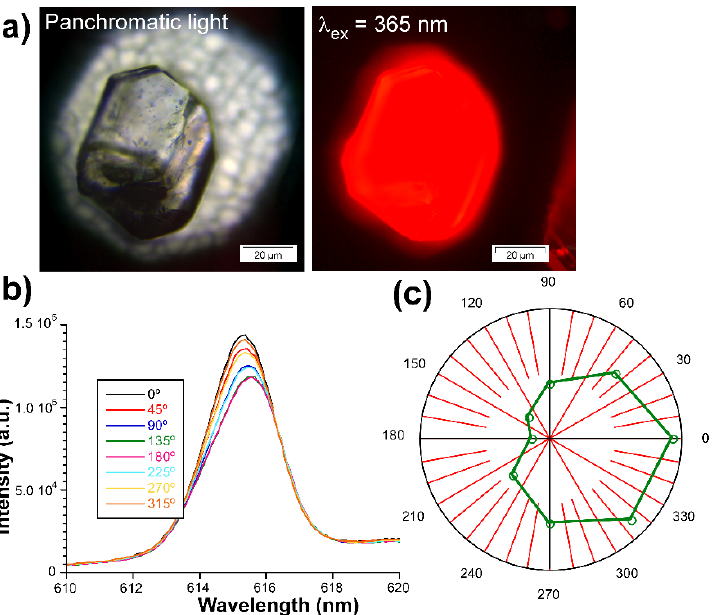
Figure 12. Measurements of the activity of 3D_Eu-L with polarized light: ( a ) optical image of the crystal illuminated with UV light, ( b ) emission spectra of the 7 F 2 ← 5 D 0 transition, and ( c ) plot showing the intensity vs. θ .